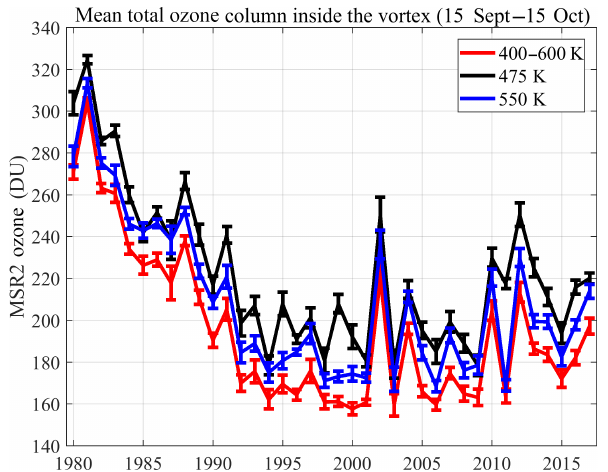
Figure 2. Evolution of total ozone of MSR-2 dataset inside the vor- tex averaged each year on 15 September–15 October period for dif- ferent classifications: standard method at 475 and 550K represented by black and blue lines, respectively, and method considering the 400–600K altitude range by the red line. Error bars represent twice the standard error.